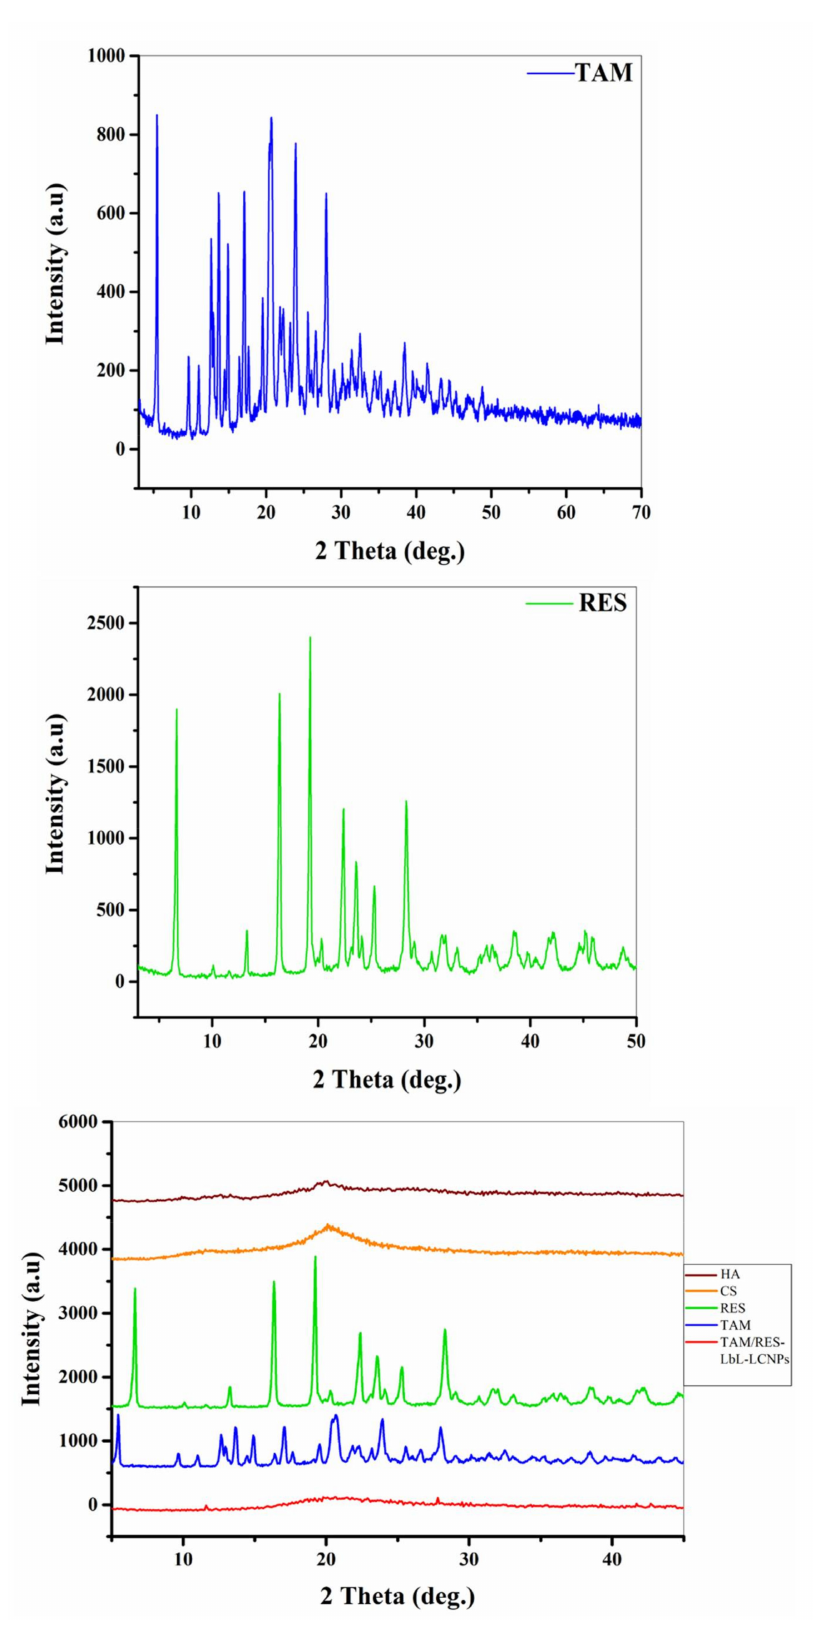
Figure 4. XRD spectrum patterns of TAM, RES, and other TAM/RES–LbL-LCNP preparation components. HA: hyaluronic acid; CS: chitosan; RES: resveratrol; TAM: tamoxifen